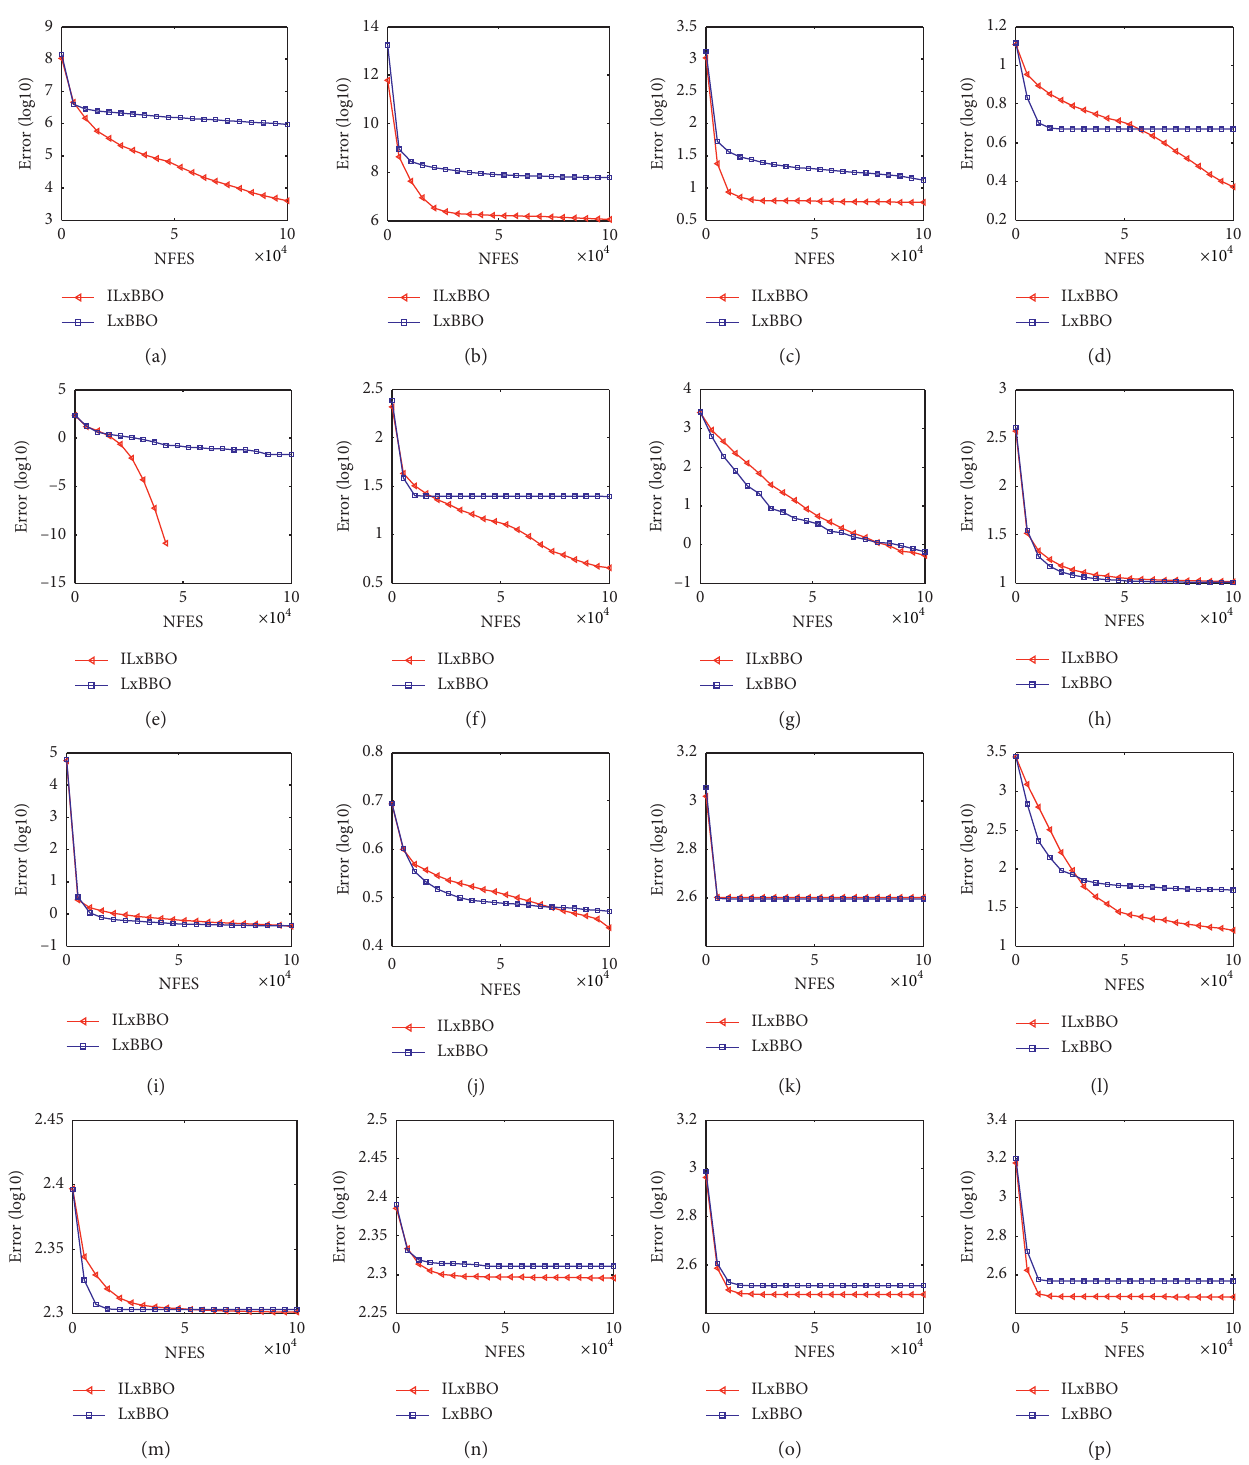
Figure 4: Convergence curves of the 2 algorithms on the 10-dimensional functions: (a) f (i) f 19 ; (j) f 20 ; (k) f 21 ; (l) f 22 ; (m) f 24 ; (n) f 25 ; (o) f 27 ; (p) f 28